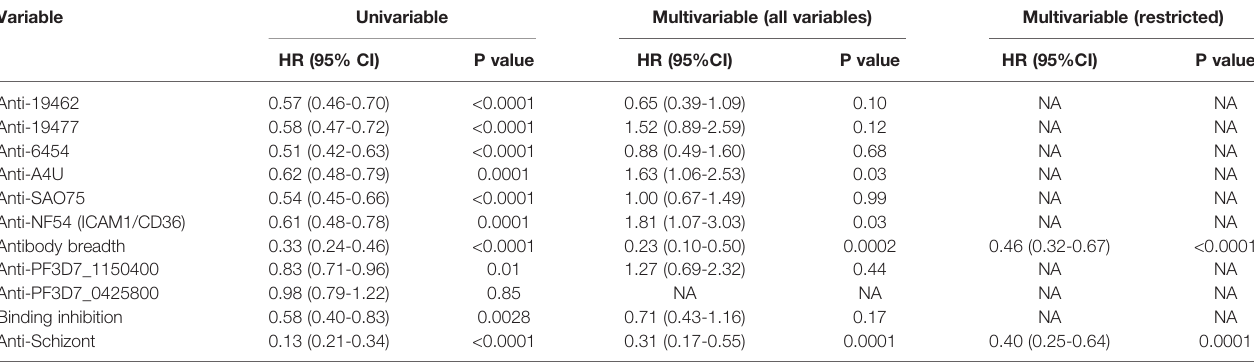
TABLE 2 | Univariable and multivariable cox regression models for risk of meeting a threshold for treatment after the challenge.